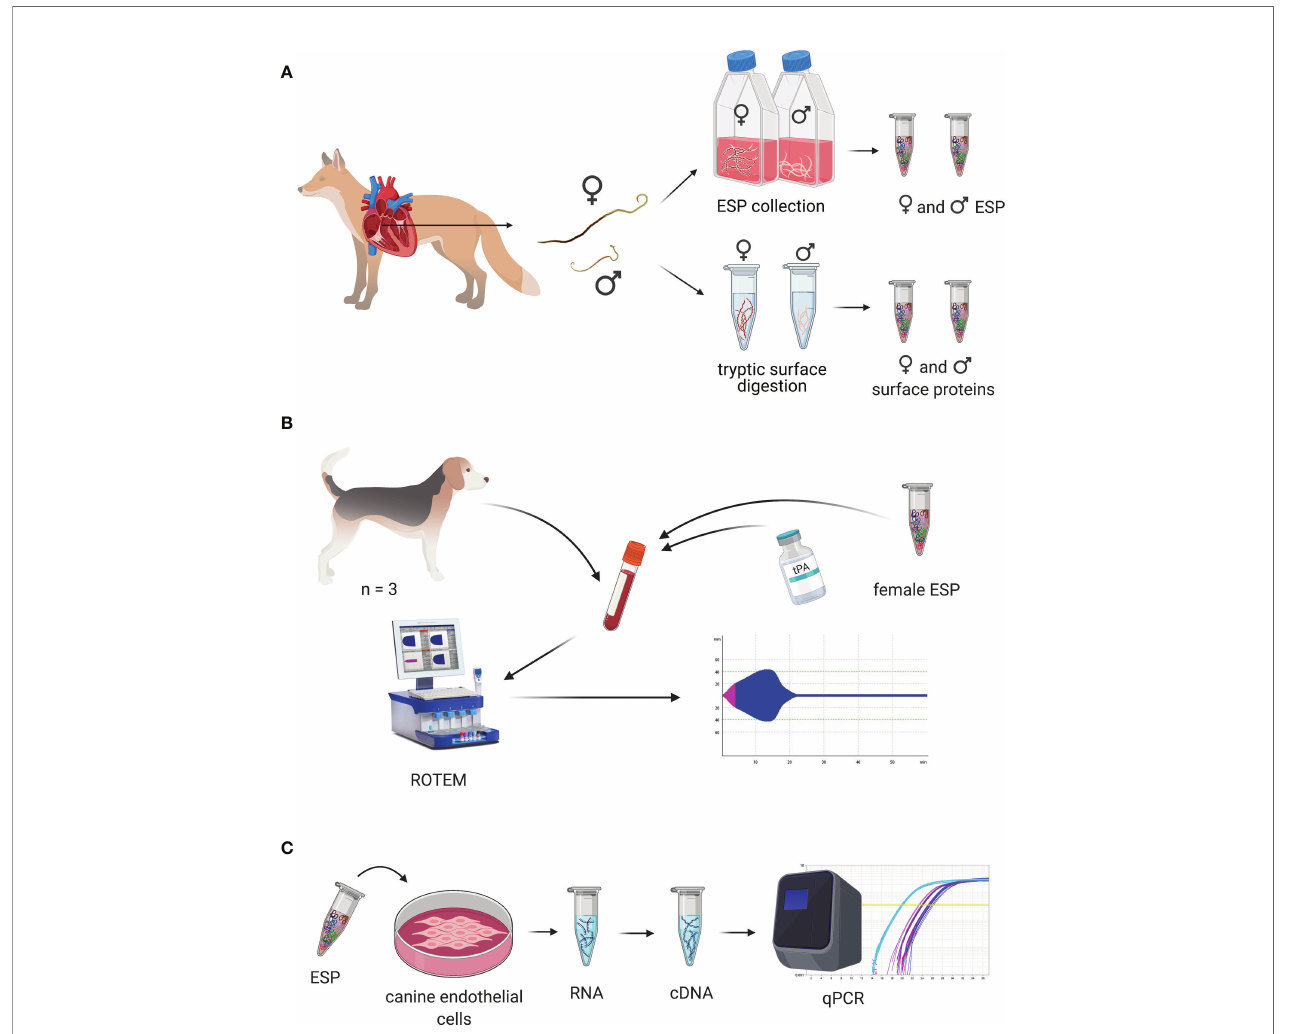
FIGURE 1 | Experimental design of the study. (A) Experimental design for collection of excretory/secretory proteins (ESP) and cuticular surface proteins. Collection of Angiostrongylus vasorum specimens from hearts of hunted foxes. Females and males were taken into culture separately for collection of female and male ESP. Cuticular surface proteins from female and male specimens were obtained by digestion of their surface. (B) Experimental design of coagulation trials. Blood was collected from healthy dogs and A. vasorum ESP and different concentrations of tissue plasminogen activator (tPA) were added to dog blood. Coagulation and fi brinolysis in the spiked blood samples was measured using rotational thromboelastometry (ROTEM). (C) Experimental design for cell stimulation trials. A . vasorum ESP was used to stimulate canine endothelial cells. RNA was collected, reversely transcribed and transcript expression of coagulation and fi brinolysis factors measured by qPCR. This fi gure was designed using